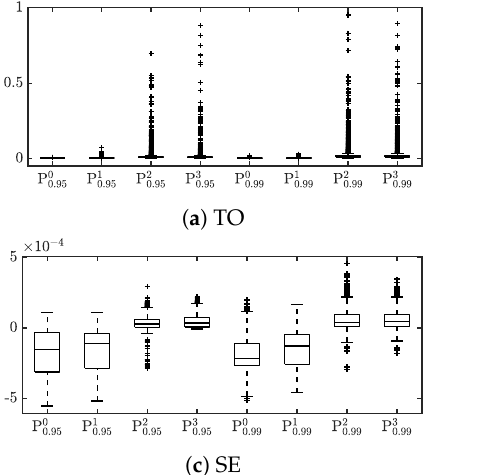
Figure 1. Box-whisker plots of the observed distributions of ( a ) TO, ( b ) AA, and ( c ) SE values for the optimized portfolios P 0 α through P 3 α .